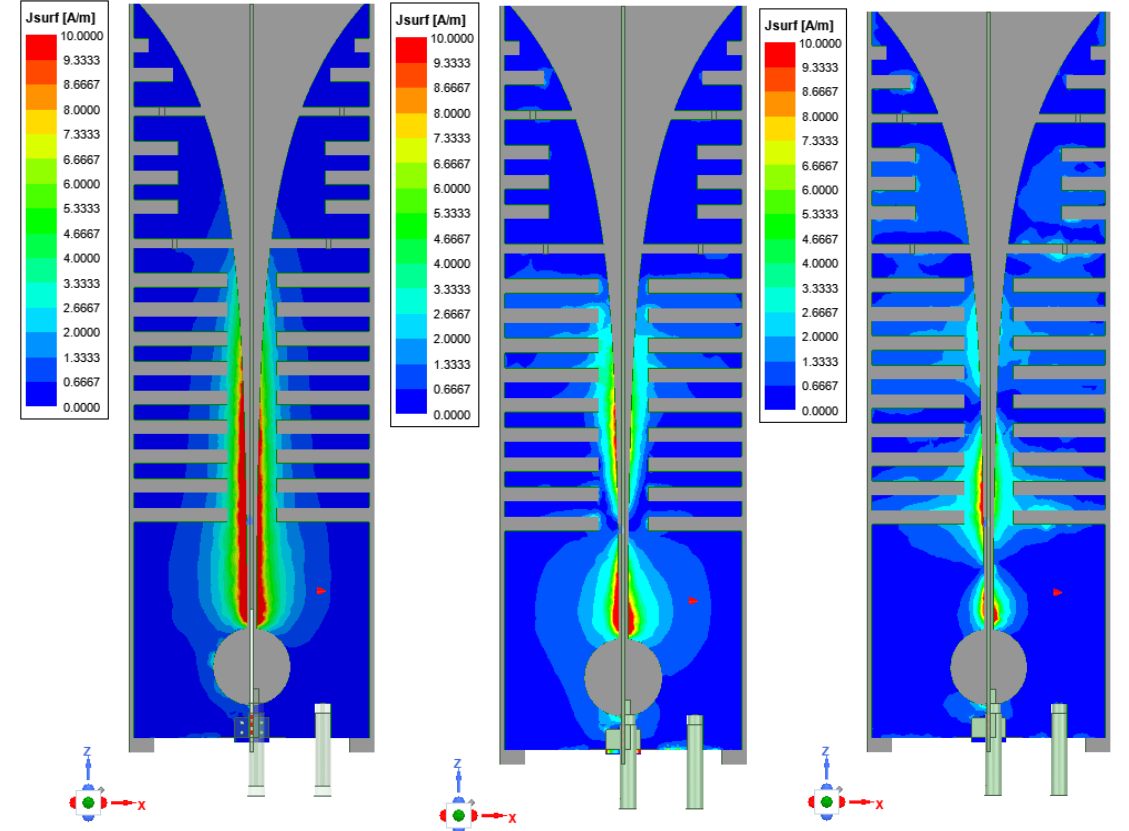
Figure 7. Vivaldi antenna surface current distributions at operating frequencies of 0.7 GHz, 2.1 GHz and 3.9 GHz.